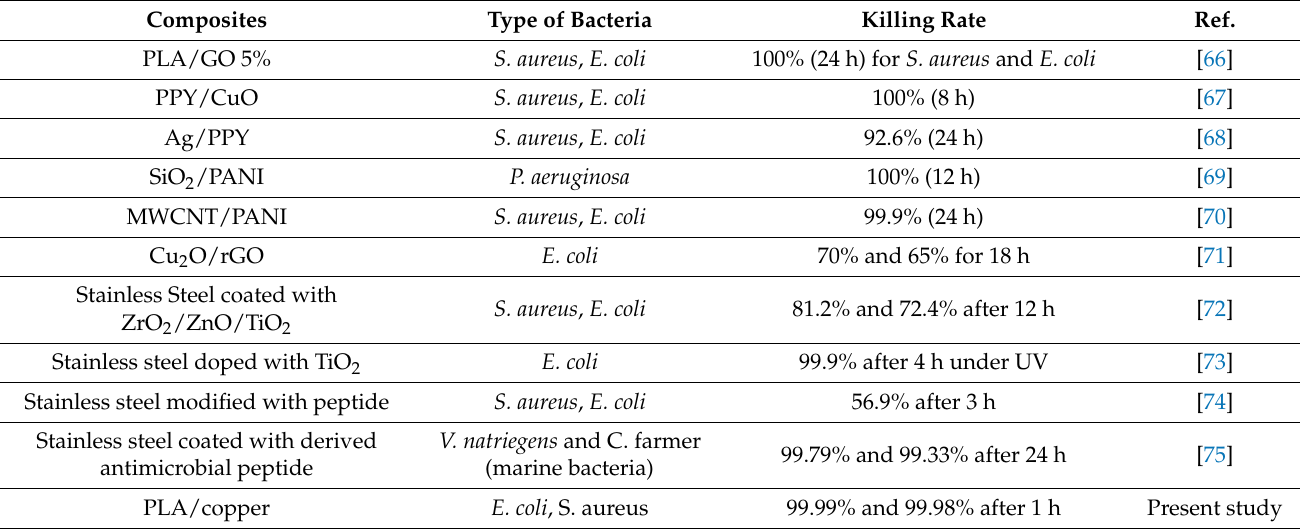
Table 6. Comparison of the present study with the different antimicrobial